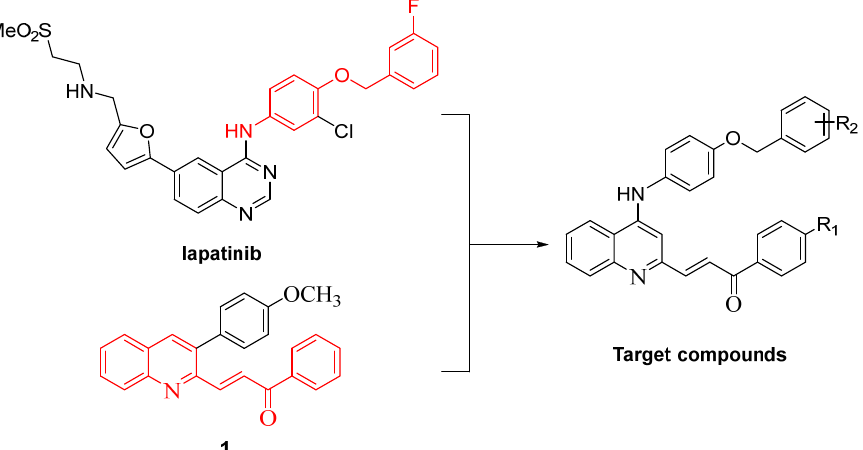
Figure 1. The target 4-(benzyloxy)aniline-quinolinylchalcone hybrids.